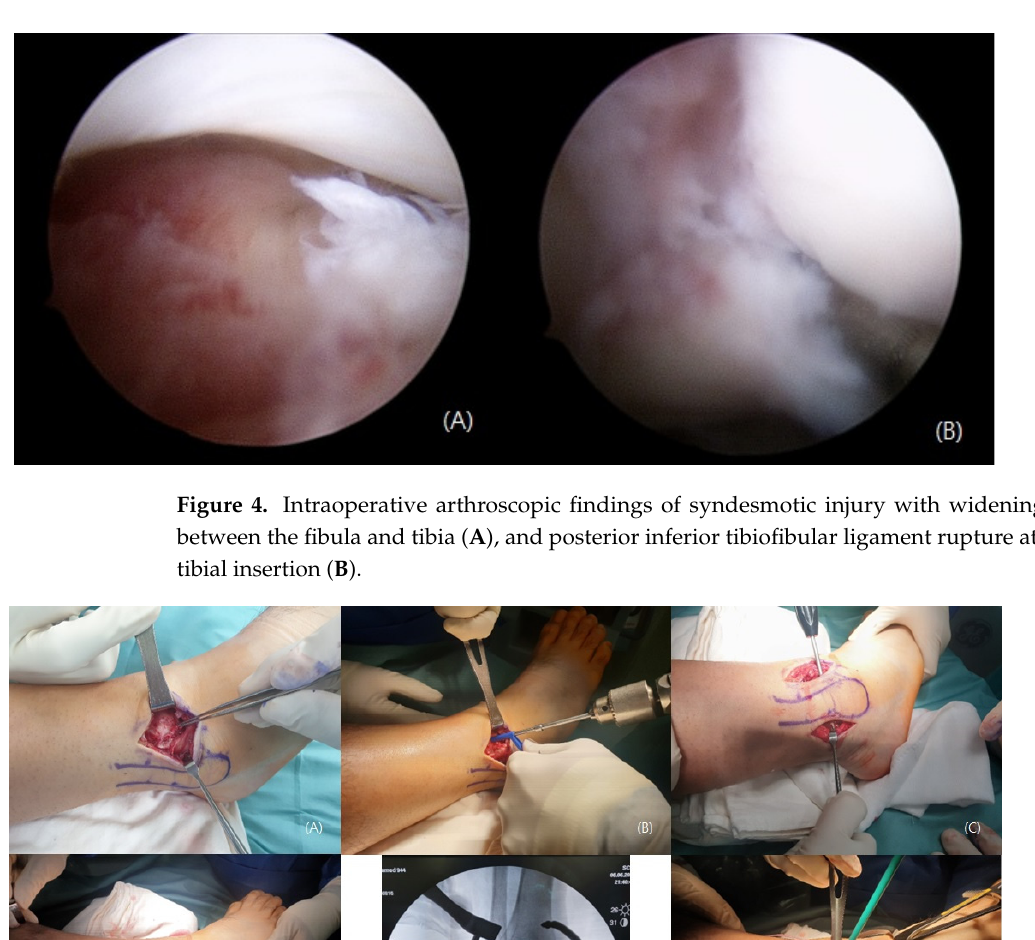
Figure 3. Coronal magnetic resonance imaging (MRI). An area of high signal intensity (red arrow) indicates a deltoid ligament injury ( A ). Axial MRI showing the anterior inferior tibio fi bular ligament (red arrow) and posterior inferior tibio fi bular ligament (red arrowhead) injuries ( B ). Axial MRI showing interosseous membrane rupture (red arrow) ( C ).